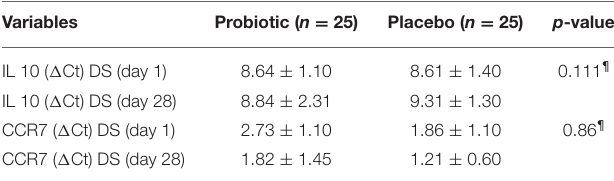
TABLE 2 | Blood inflammatory markers ( 1 Ct), in infant with colic at enrolment and after 28 days of supplementation with L. reuteri or Placebo.